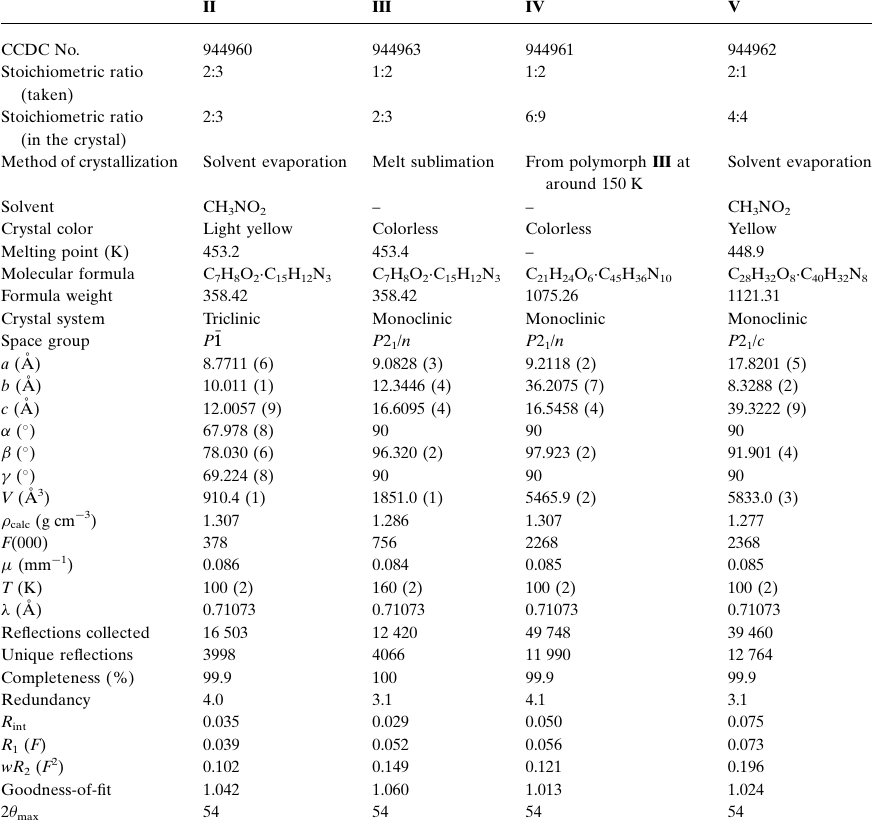
Table 1 Crystallographic details of forms II through to V .